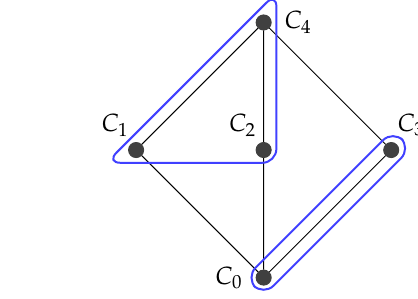
Figure 5. Concept lattice isomorphic to M 3 and induced partition by D M